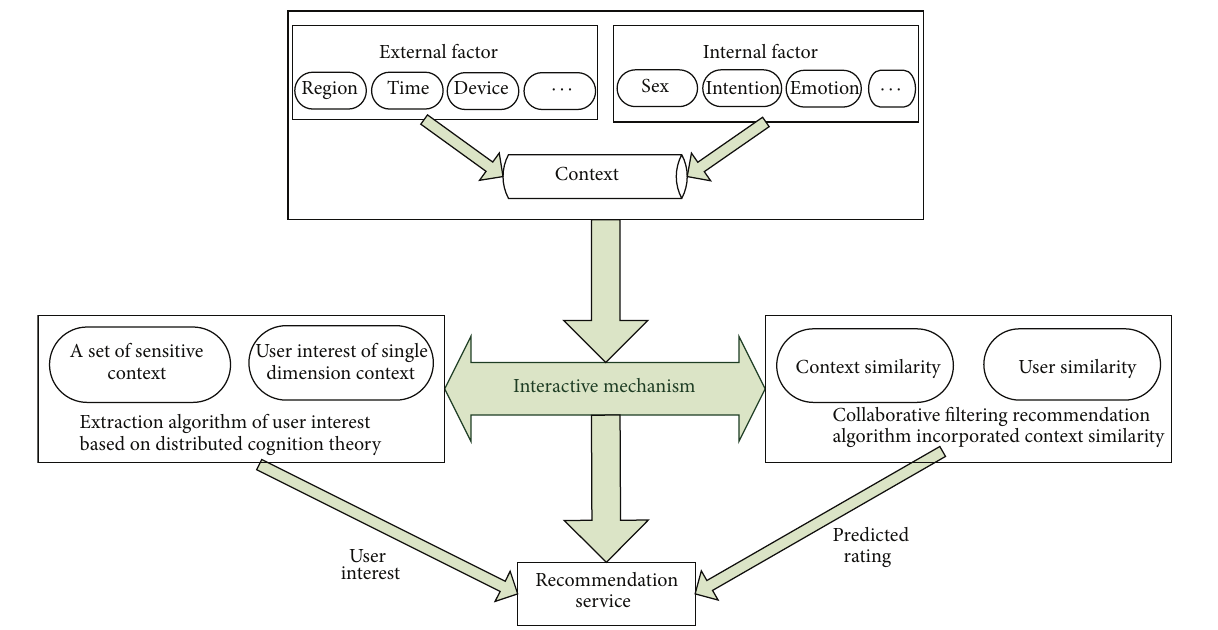
Figure 1: Contextual information recommendation model based on distributed cognition